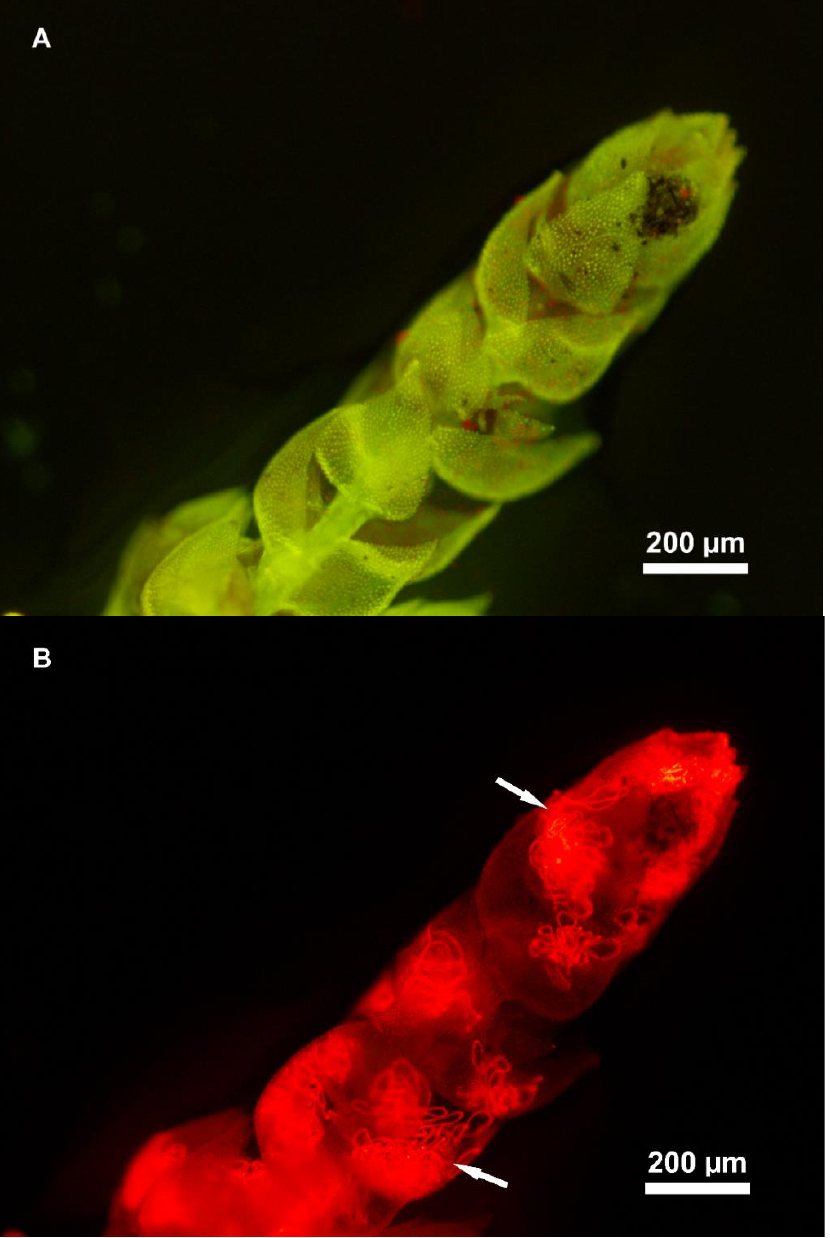
Figure 1. Epifluorescence microscopy image of one shoot of Thuidium peruvianum moss collected in a tropical montane cloud forest in south-eastern Peru (40 × magnification — Olympus BX61), image with a blue filter ( A ) and image with a green filter ( B ), note the epiphytic cyanobacteria filaments (arrows) in association with the moss shoot. Images: L. A.